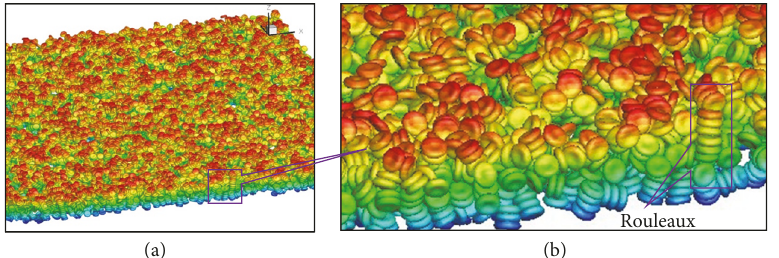
Figure 10: Three-dimensional view of the simulation results at shear rate 60 s −1 : (a) overall view and (b) local view of the rouleaux structures.